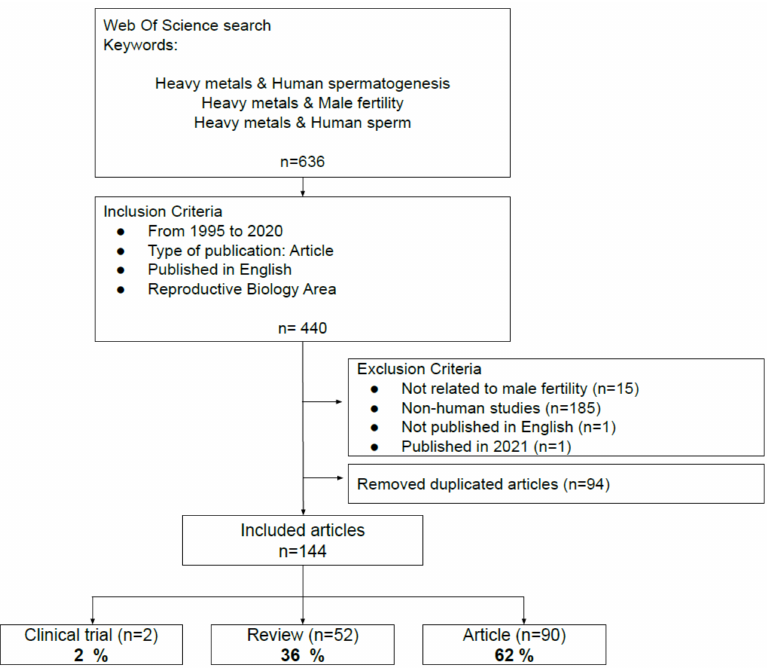
Figure 1. Flowchart summarizing the selection process of the articles included in the present review.